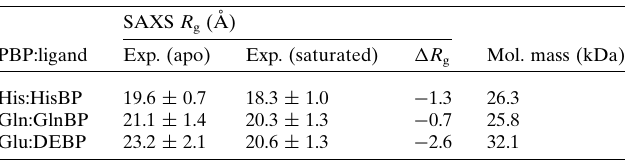
Table 3 Experimental SAXS R g of HisBP, GlnBP and DEBP representative profiles, collected for apo and ligand-excess conditions. See Table S5 for the full report.